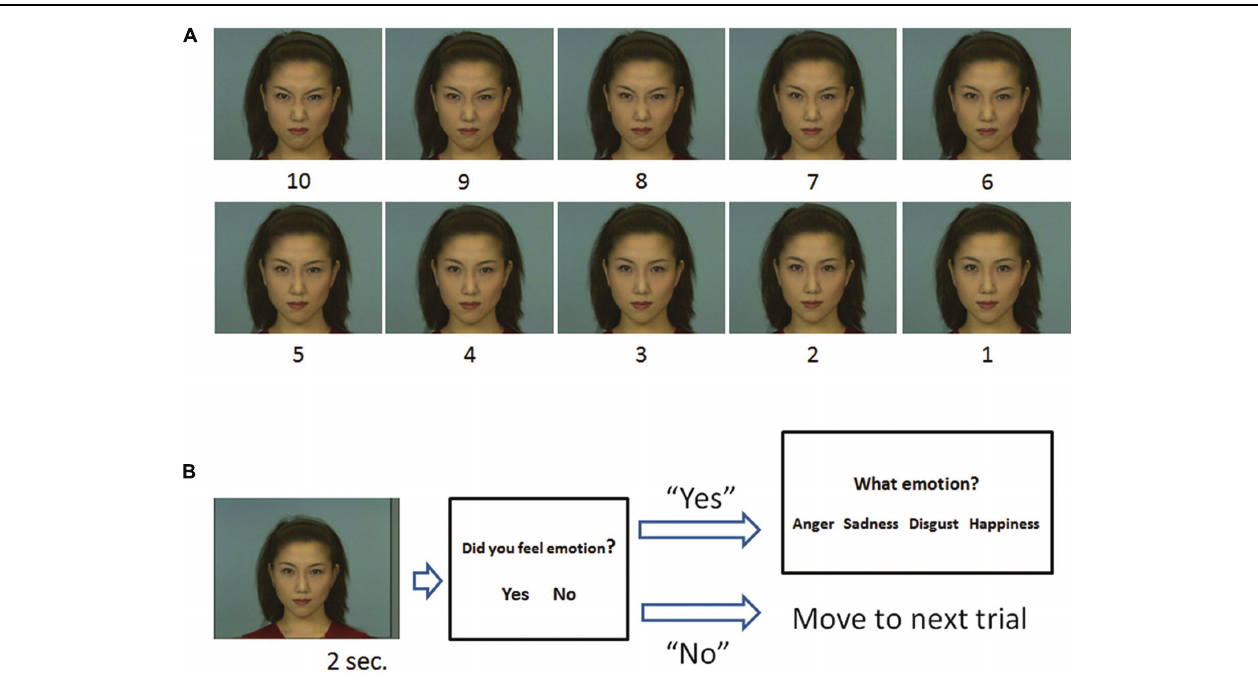
FIGURE 2 | The stimuli used in the task (A) and outline of a trial (B). (A) Morphed continua photos ranging between neutral (stimulus 1) and 100% of each facial expression (stimulus 10), i.e., angry. (B) A stimulus was followed by a judgment about whether the stimulus elicited an emotion. If participants responded “yes,” options were presented and they were asked to choose the most appropriate emotion